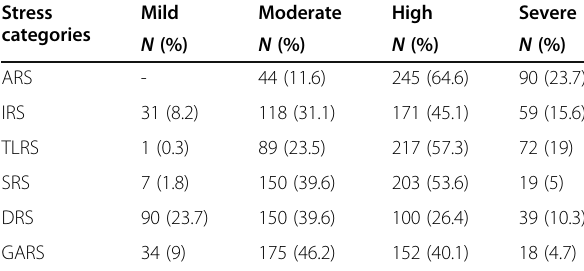
Table 2 Frequency of exposure to stress categories